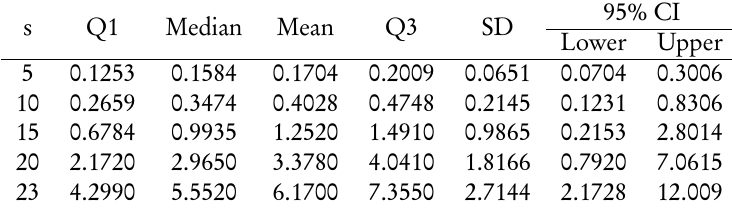
Figure 6 – Two Sample Survival functions for different values of s for real data set. Sample based two-sample predictive posterior characteristics from scheme 3 for the real data